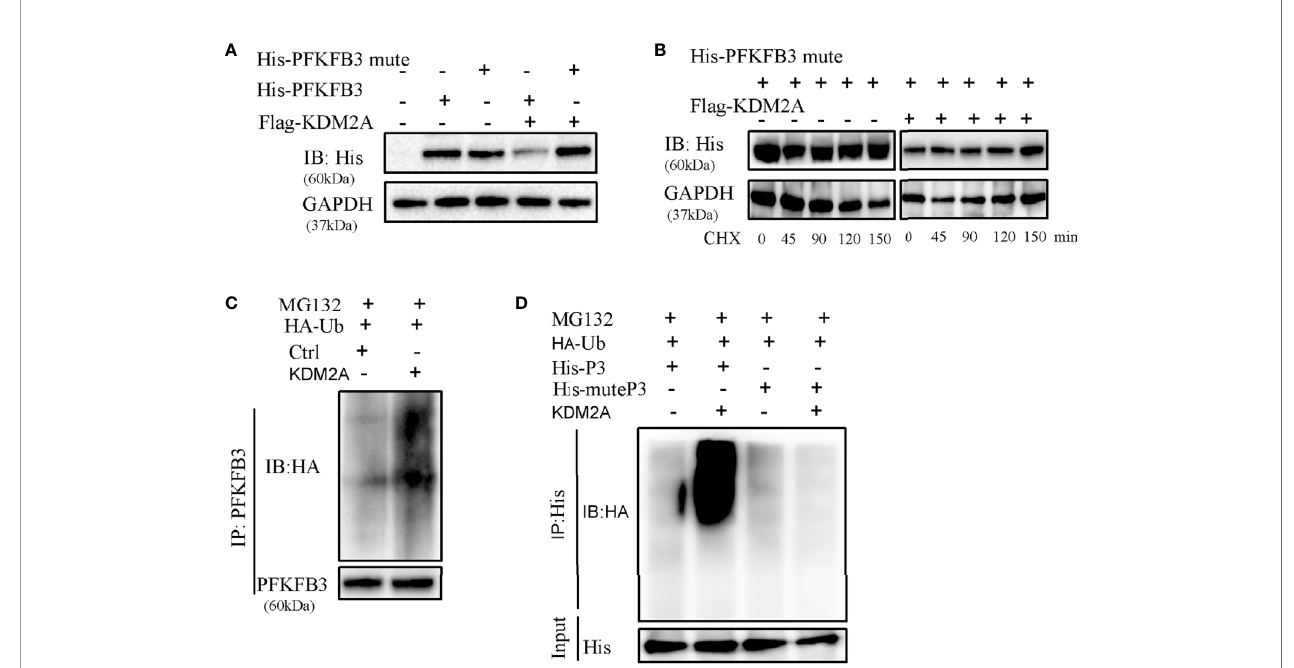
FIGURE 5 | Determination of interaction between KDM2A and PFKFB3. (A) Detection of the effect of KDM2A on PFKFB3 or PFKFB3 mutant degradation in 293T cells. (B) The turnover rate of PFKFB3 mutant was not changed in response to KDM2A overexpression with CHX treatment. (C) KDM2A generated ubiquitylation on